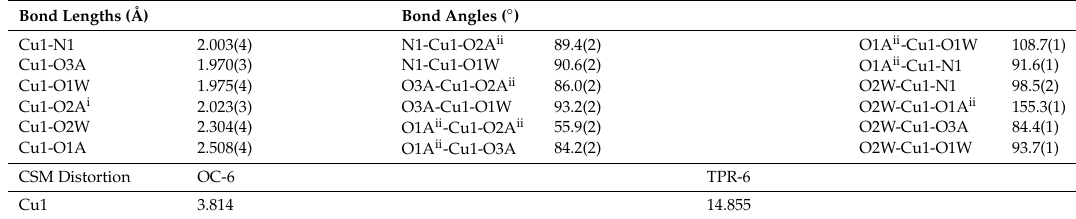
Table 1. Bond lengths and angles for Cu(II) centers in 1 , together with the values for CSM. Bond Lengths